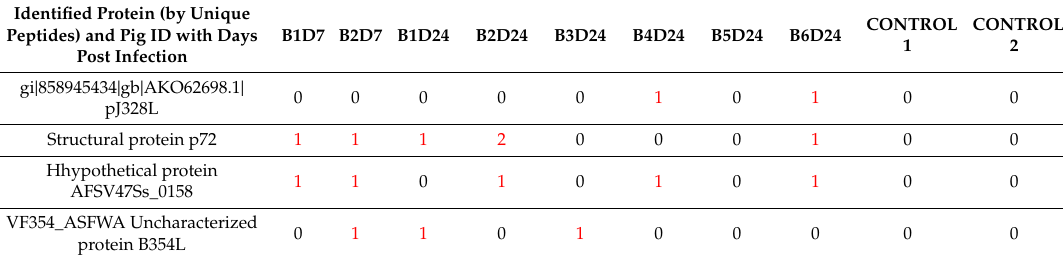
Table 2. Identified viral proteins in the Benin ∆ MGF group of porcine serum-derived EV-enriched fractions at 24 days post infection. Columns correspond to each animal at di ff erent time points (Group B, 7 and 24 dpi) where unique peptides were identified